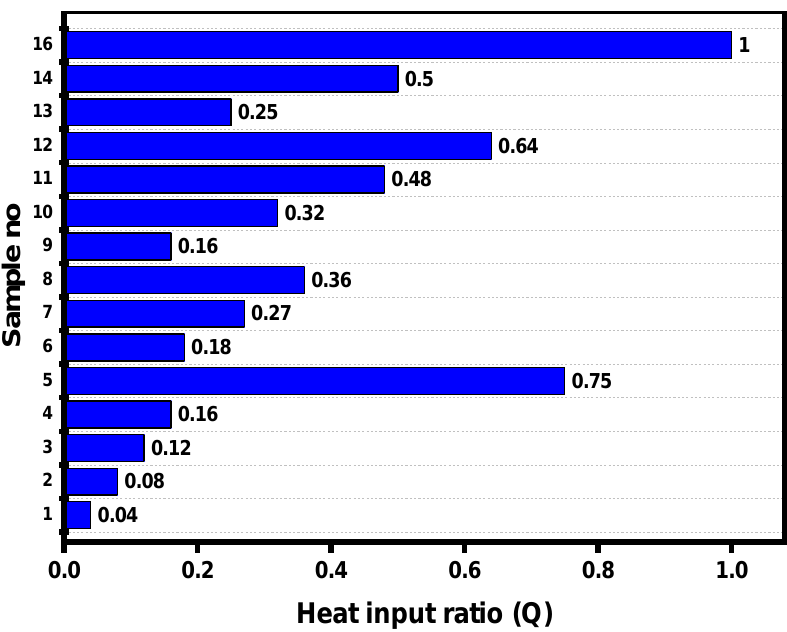
Figure 11. Heat input ratio of DPWs. (Reprinted from [26] with permission from Elsevier)